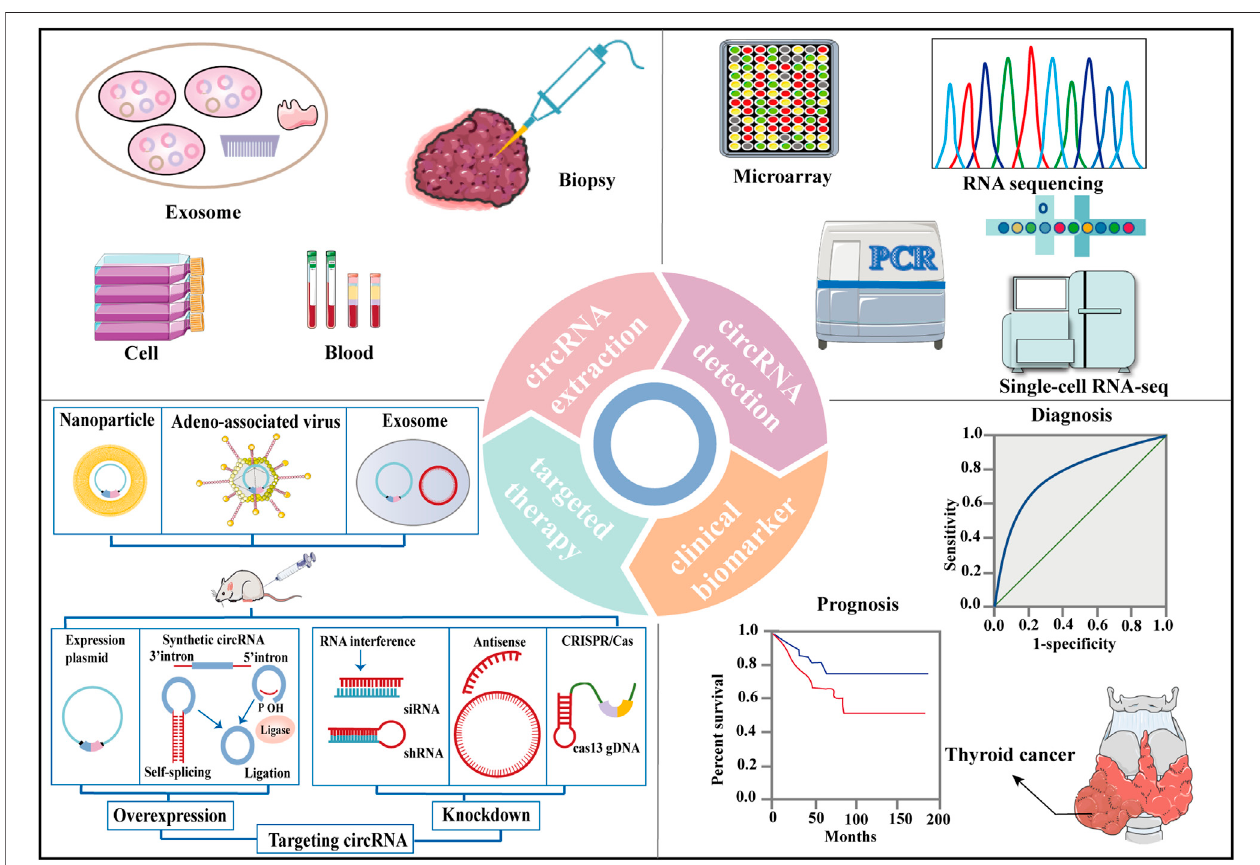
FIGURE 4 | Clinical applications of circRNAs in thyroid cancer. CircRNAs are extracted from cell, blood, biopsy and exosome from TC patients. RNA sequencing, microarray,single-cellRNA-seq,quantitativereversetranscriptase-polymerasechainreaction(qRT-PCR)assaysaremethodsthatcanbeusedtodetectcircRNAlevels. CircRNAsaresigni fi cantlyassociatedwithmanyclinicopathologiccharacteristics ofTCandwithTCpatientsurvivalparameters,renderingthempotentialdiagnosticand prognostic biomarkers for TC. Overexpression or knockdown of target circRNAs resulting from delivery may serve as potential therapeutic approaches for TC.